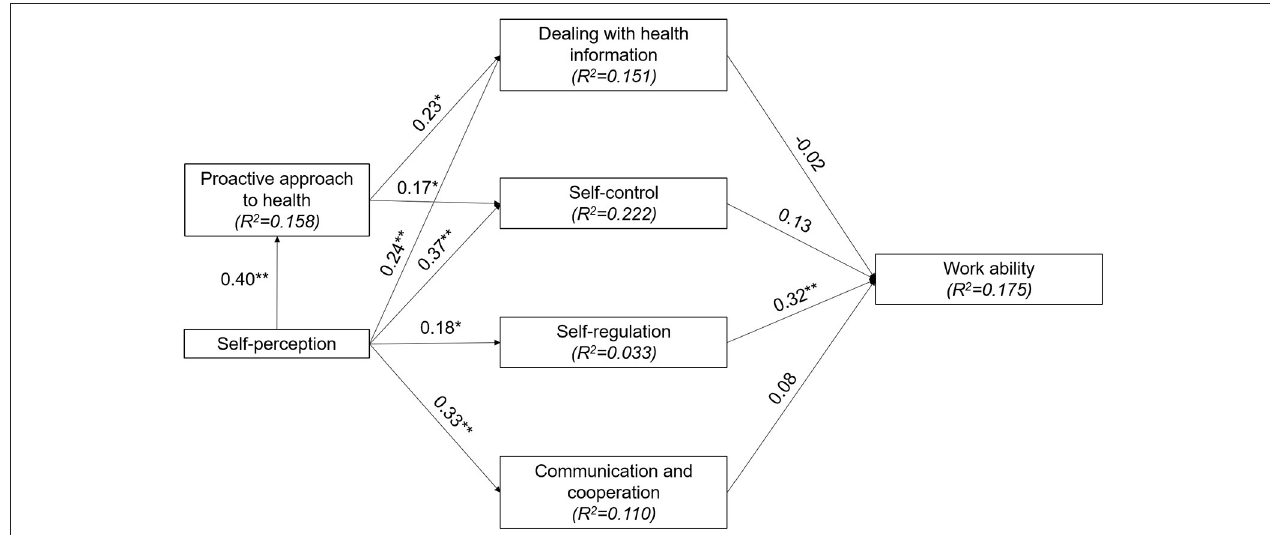
FIGURE 2 | Structural model of health literacy including work ability with determination coefficients ( R 2 ) and path coefficients. * p < 0.05, ** p < 0.01.